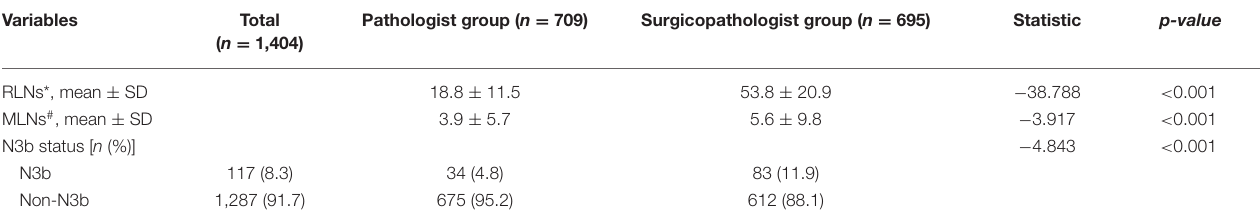
TABLE 2 | The number of retrieved lymph nodes and metastatic lymph nodes and the dectecting of N3b status in the two groups.